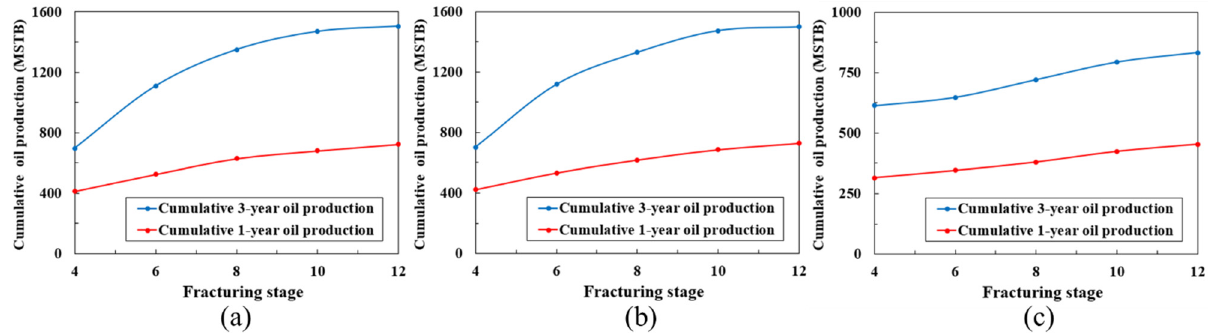
Figure 10. Cumulative oil production of stimulation in ( a ) Type I, ( b ) Type II, ( c ) Type III.